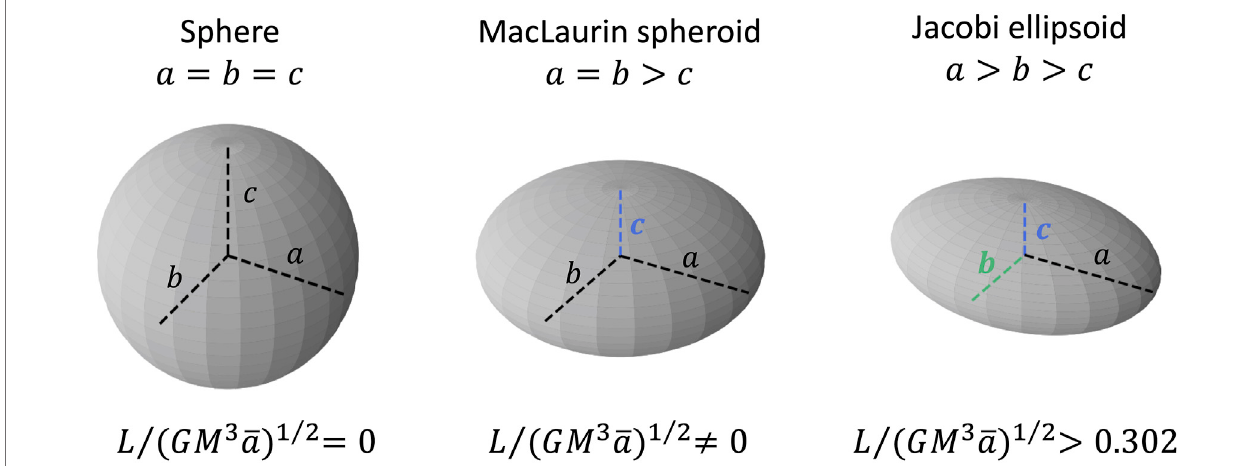
FIGURE 1 | Equilibrium shapes for homogeneous